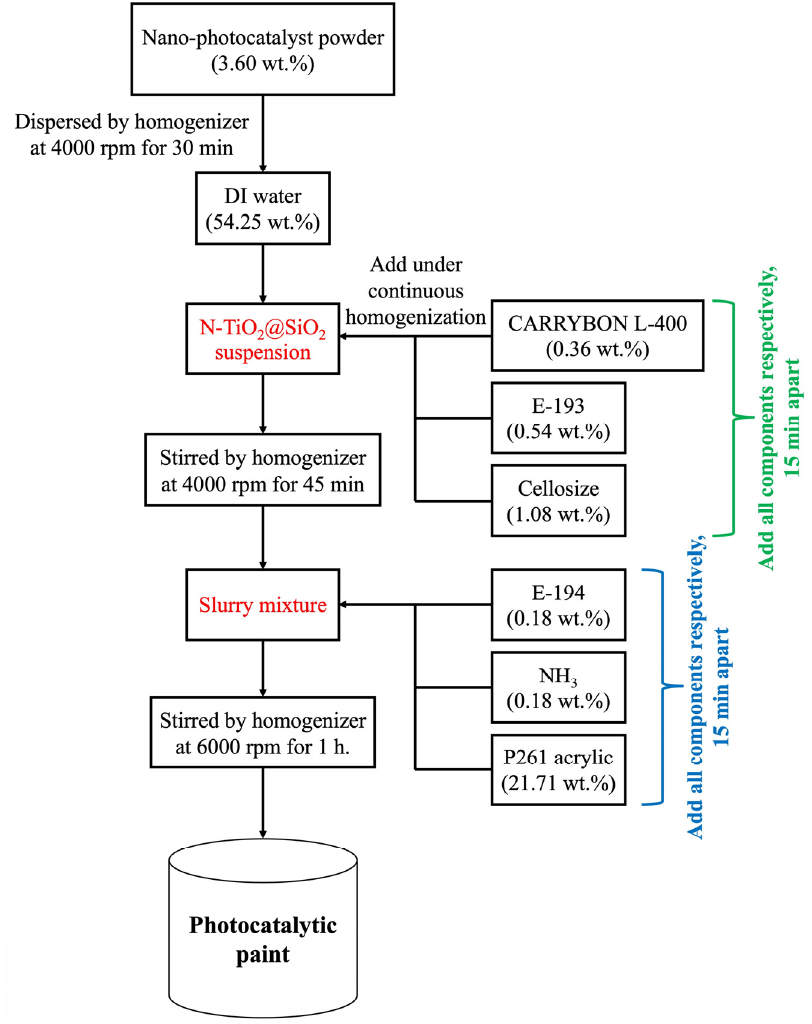
Figure 12. Schematic illustration of nano-catalyst paint preparation.